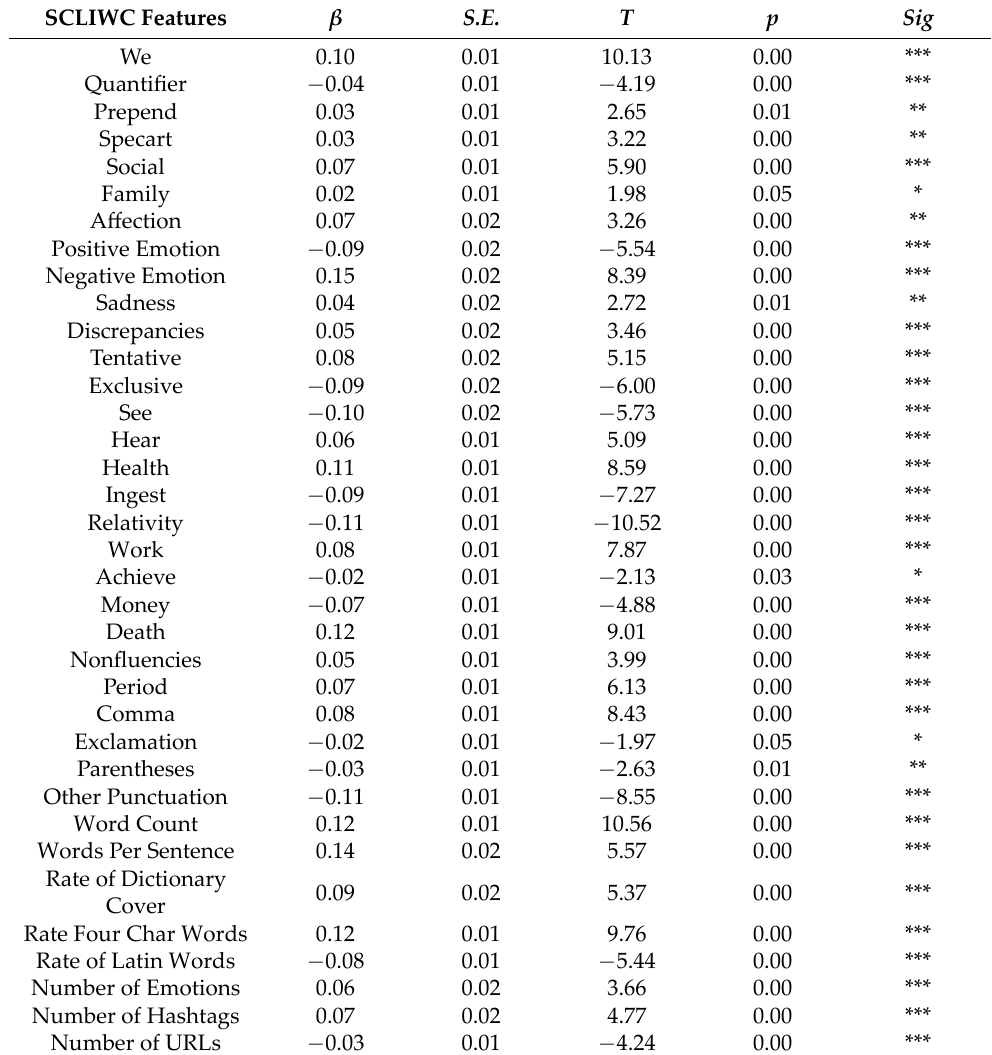
Table 2. Linear regression model using the simplified Chinese version of LIWC (SCLIWC) features to predict suicidal ideation